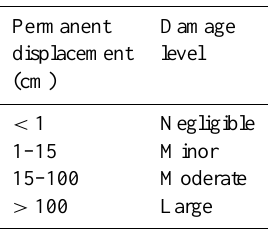
Table 6. Scale of damage level as a function of the values of perma- nent displacements (after Bray and Travasarou,